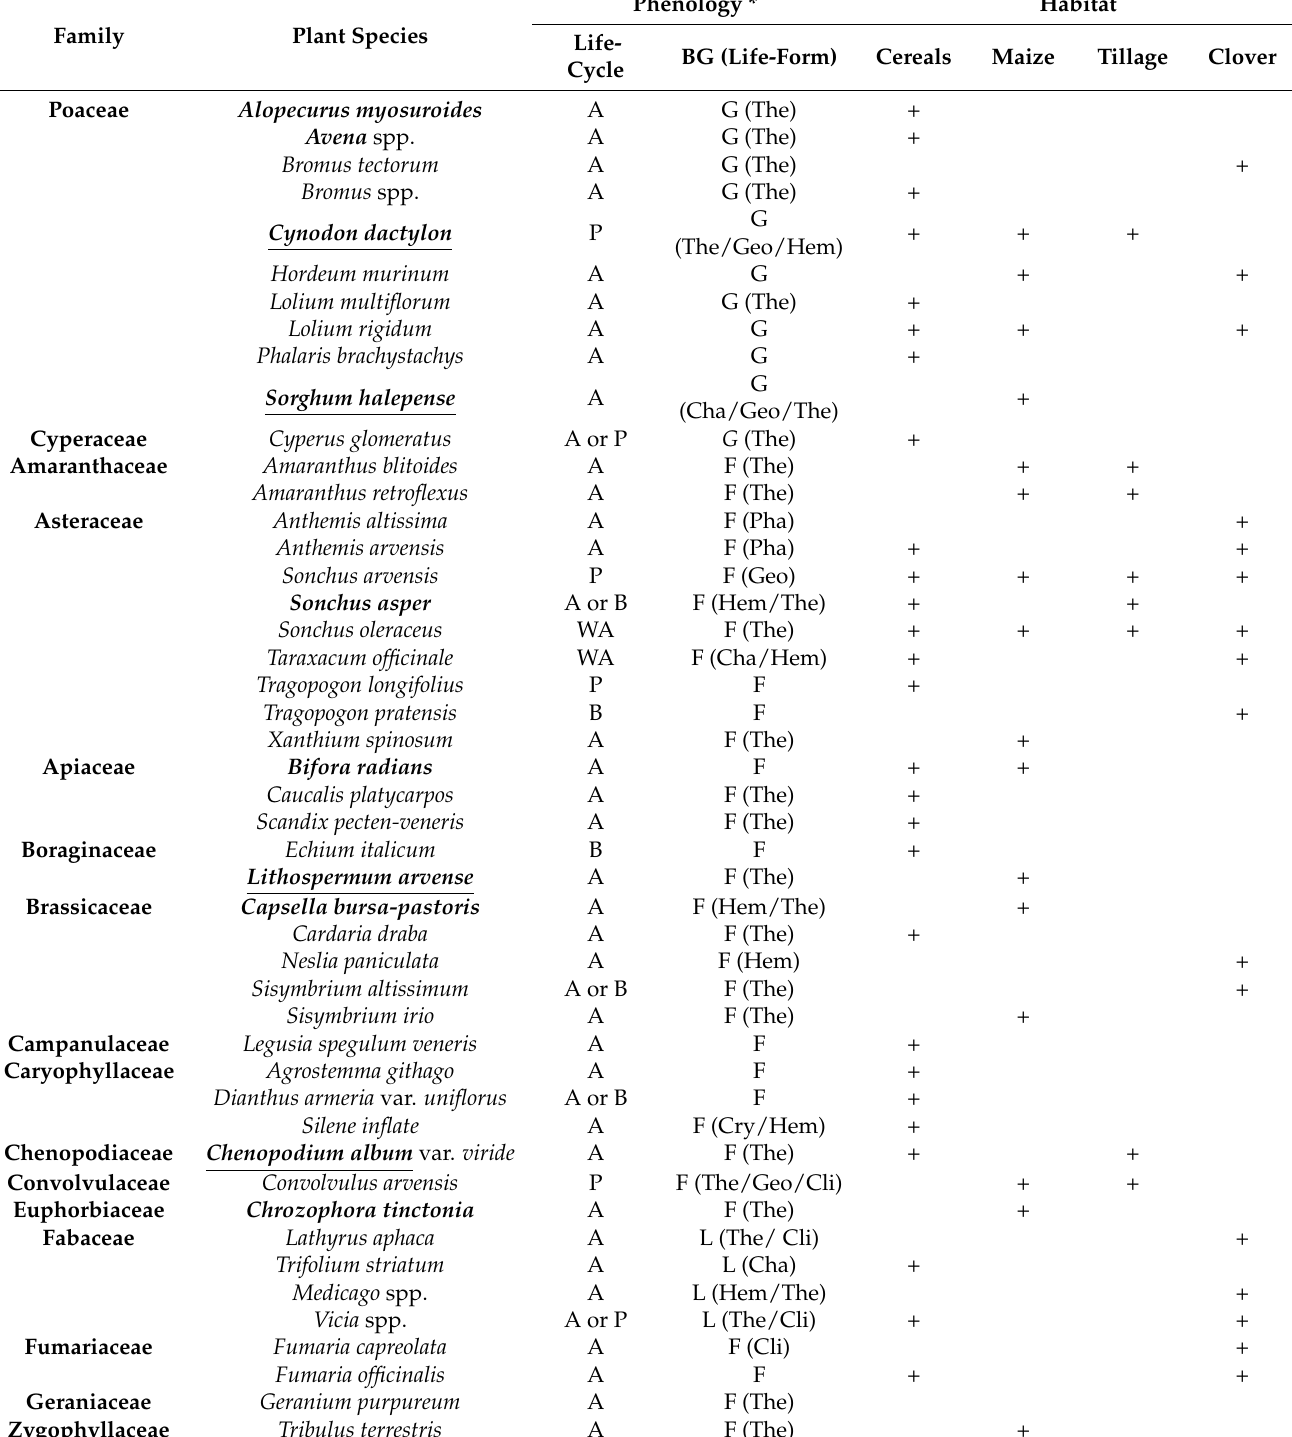
Table A1. Presence (+), total species richness and phenology of 61 herb-layer non-cultivated species of 25 families (11 grasslike species and 50 broadleaf (4 legumes and 46 forbs) herb-layer species) in Cereals, Maize, Clover, and Tillage in Dolichi plain during the growing season of 2006 (from